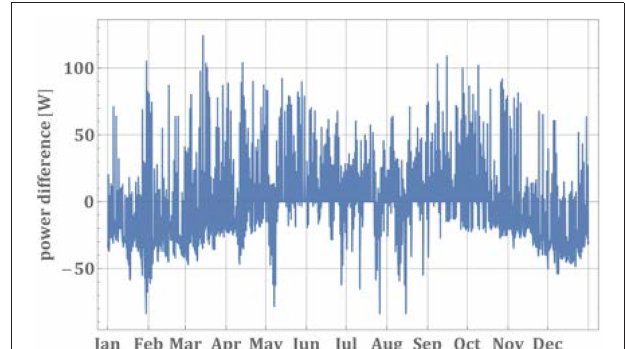
FIGURE 10 | Power difference between on-device PV generation and device